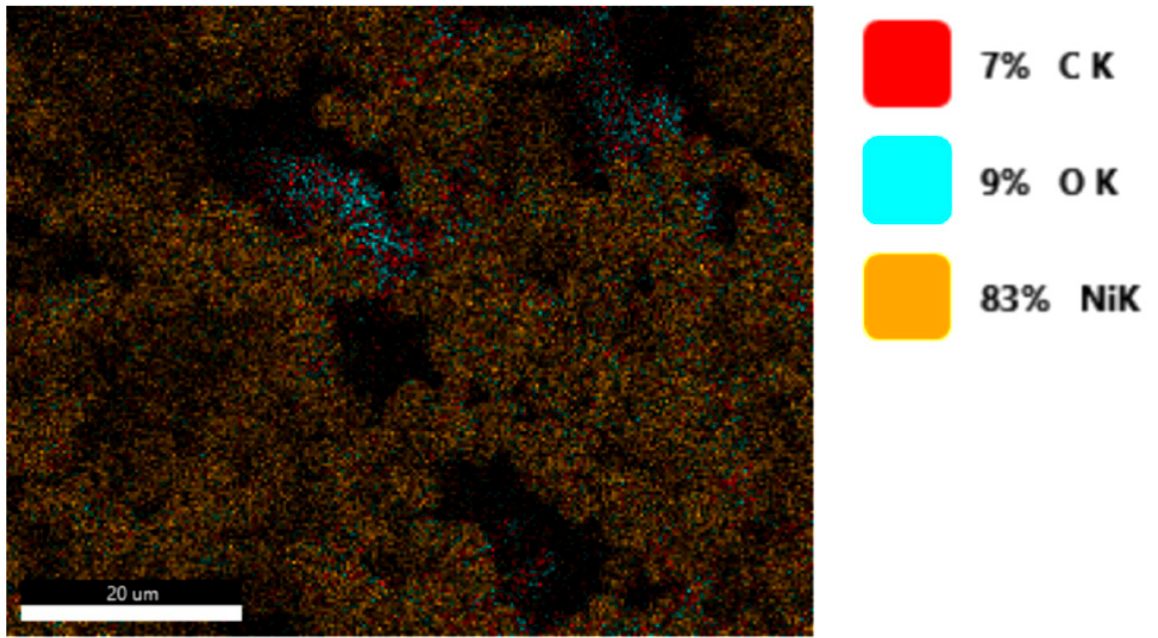
Figure 14. ESD spectra and elemental overlay for sample S2 treated in RF plasma O 2 , using RF 1 generator and power 200 W and Ni paste.